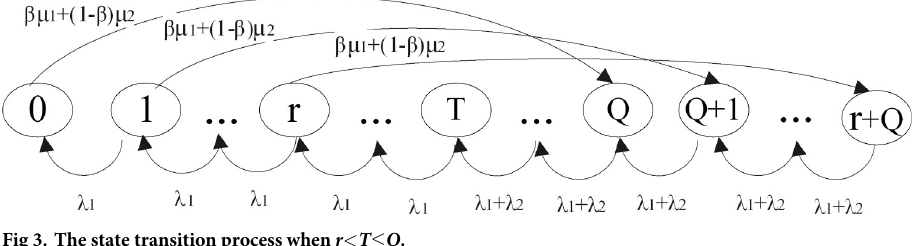
Fig 3. The state transition process when r < T � Q . process Fig 2, the following balance Eqs (1)–(7) can be written by the fact that transition out of a state is equal to transition into a state for a Markov process. For example, if the inventory level state j lines in the range Q � j � Q + r − 1, the equation is presented in Eq (2). When j is within this range, there is no order pending, and then transition beyond this state can be only due to either an ordinary customer arrival or a priority customer arrival, which is presented on the left-hand side of Eq (2). Either an ordinary customer or a priority customer arrival in state j +1 will lead the inventory level to reduce by one unit, thus bring it to state j . State j can also be reached from state j − Q when an order with fixed Q arrives at intensity Z = β μ only two possible ways of reaching state j are reflected on the right side of Eq (2).